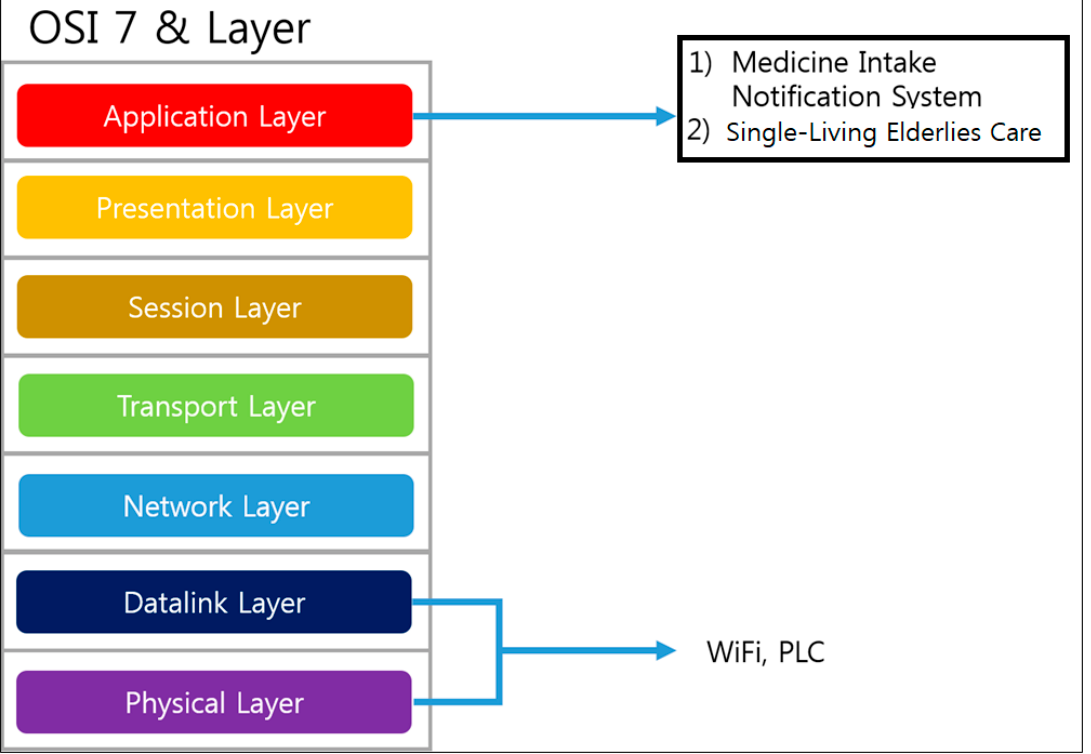
Figure 1. The Range of Test Bed Experiments of the Framework for the Single-Living Senior Citizens Care.